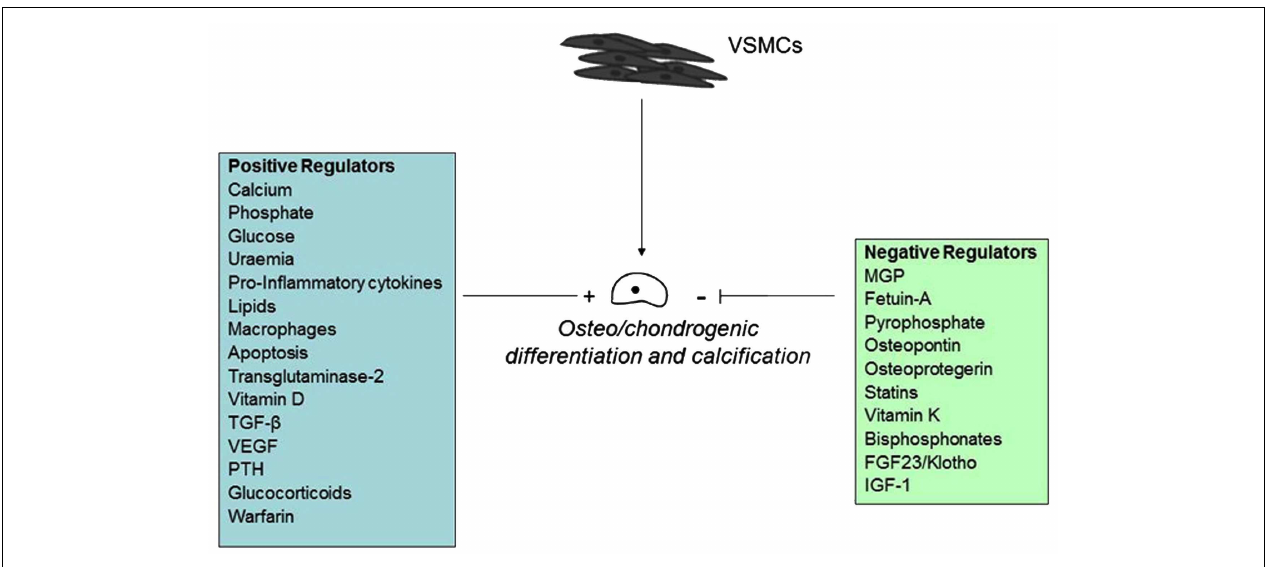
FIGURE 4 | Positive and negative regulators of vascular